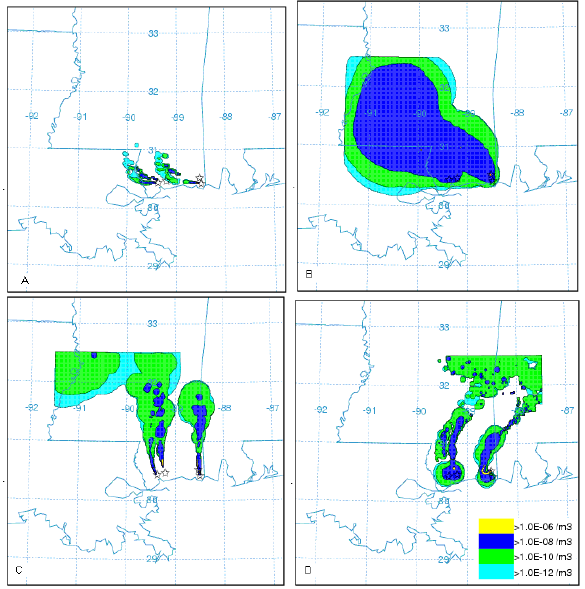
concentrations (g m -3 ) averaged for 1 hour Figure 18 : SO 2 intervals in the lowest 50 m computed by Hysplit model for A)10 UTC 28 June, B)17 UTC 28 June, C)03 UTC